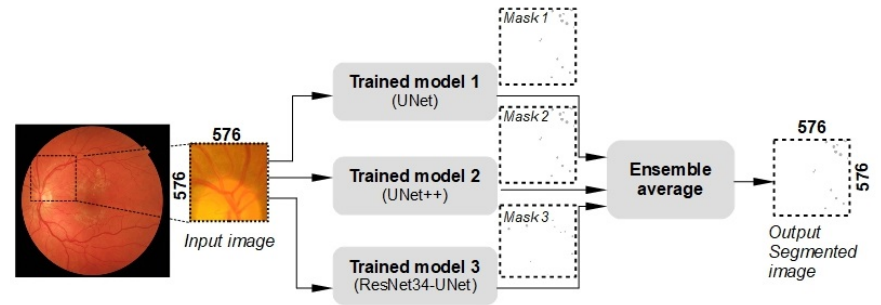
Figure 8. Functional diagram of the proposed ensemble-based segmentation model.